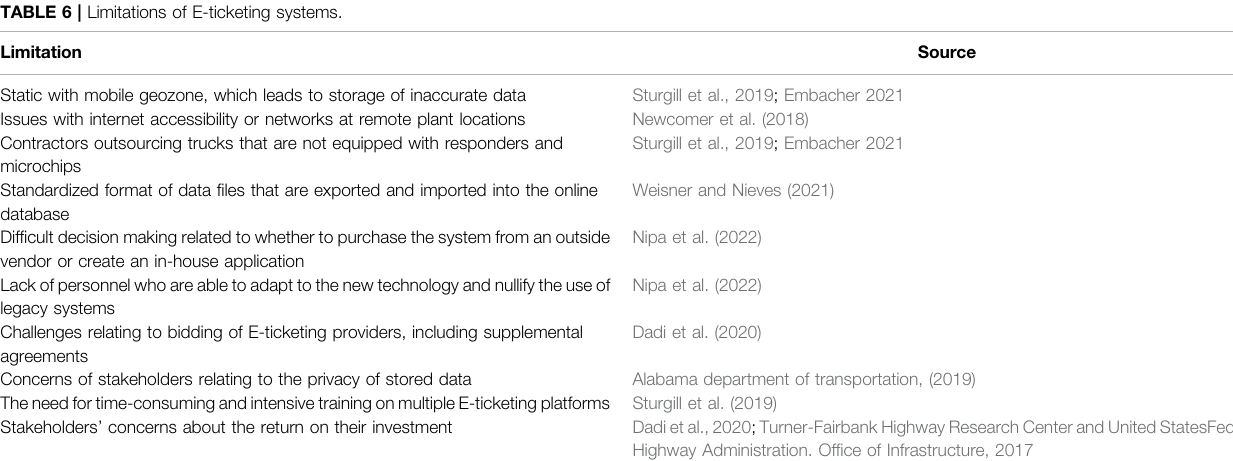
TABLE 6 | Limitations of E-ticketing systems.